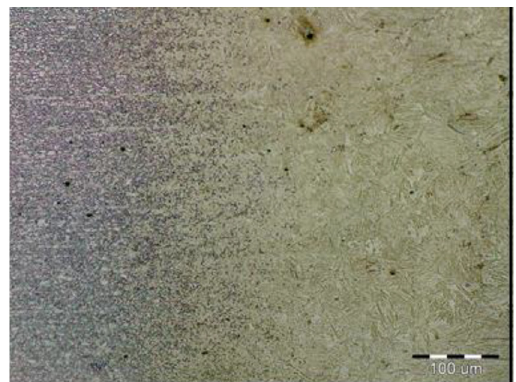
Figure 18. Narrow transition area base material to thermally affected area (TRIP).